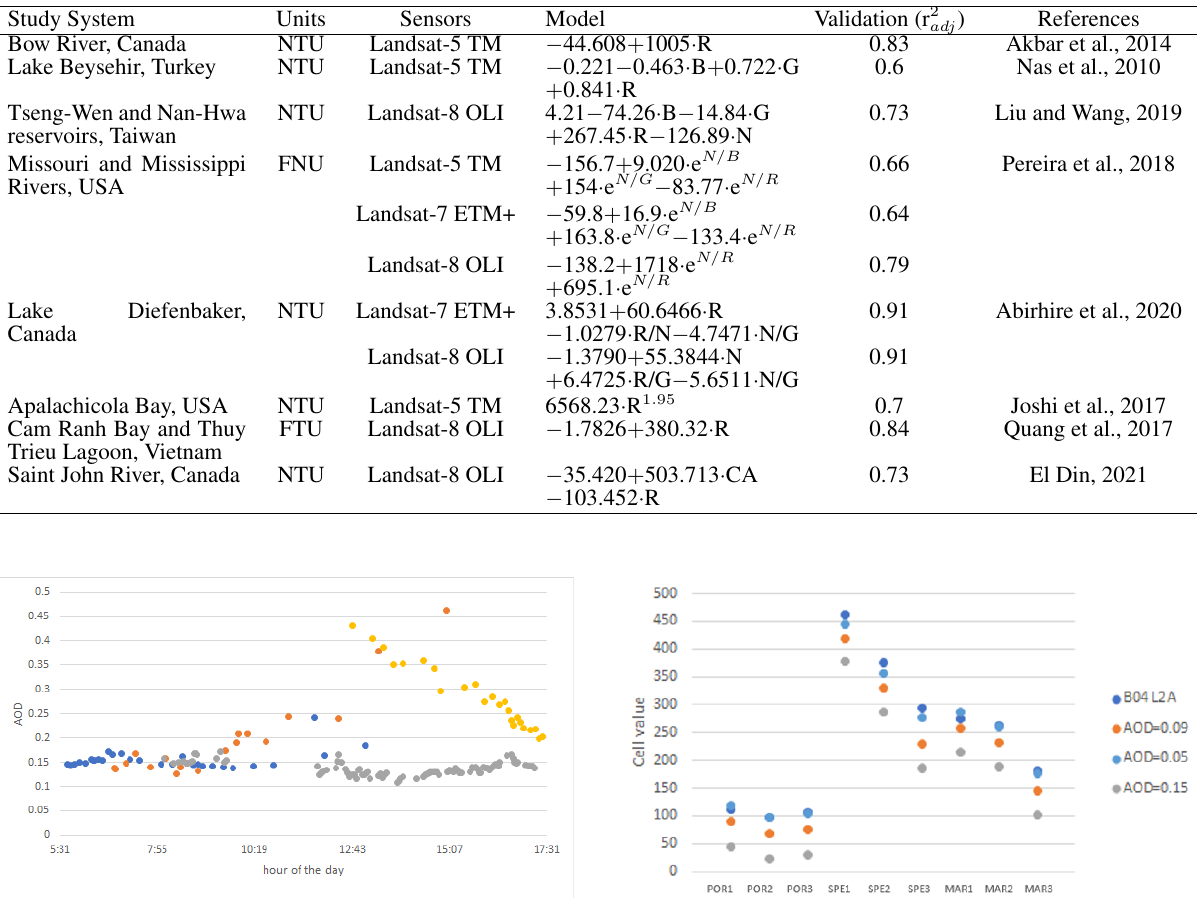
Table 1. Turbidity models and validation considering several studies (adapted from Abirhire et al., 2020). NTU, FNU and FTU stand for Nephelometric Turbidity Units, Formazin Nephelometric Units, and Formazin Turbidity Units, respectively. B, G, R and N are blue, green, red and near infrared bands, respectively. CA is coastal/aerosol band.